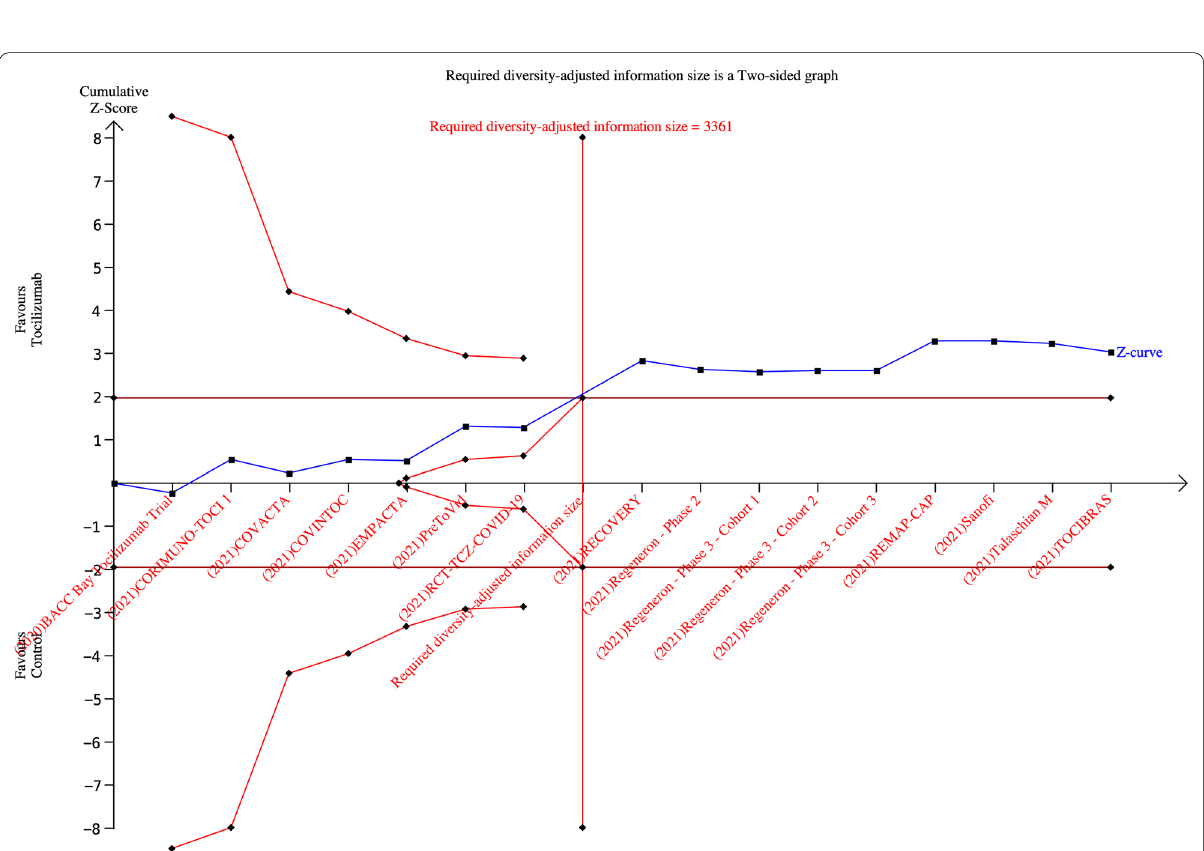
Fig. 3 Trial sequential analysis for primary